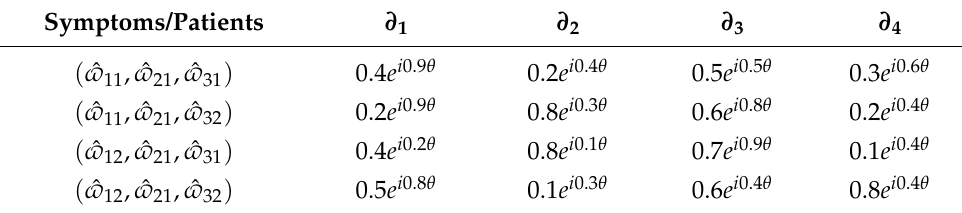
Table 6. (cid:116) z ε F : C FH S union of z 1 F and z 2 F